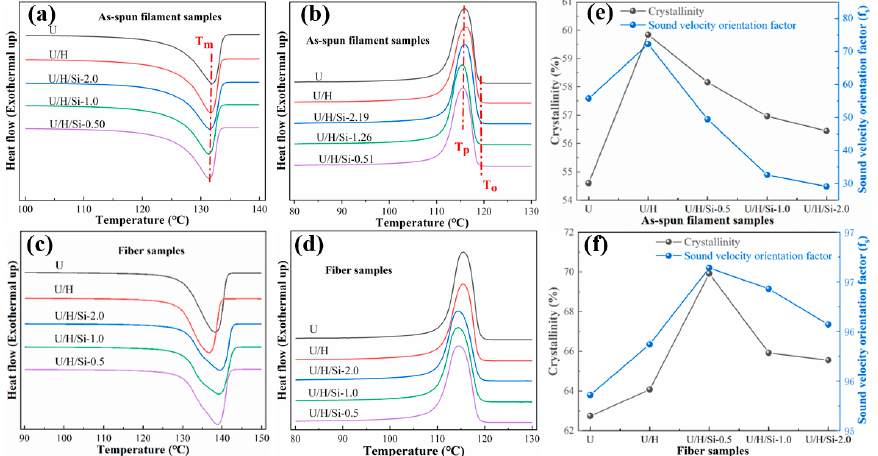
Figure 6. ( a – d ) DSC curves of all as-spun filament and fiber samples; ( e ) Crystallinity and sound velocity orientation factor of as-spun filament samples; ( f ) Crystallinity and sound velocity orienta- tion factor of fiber samples.